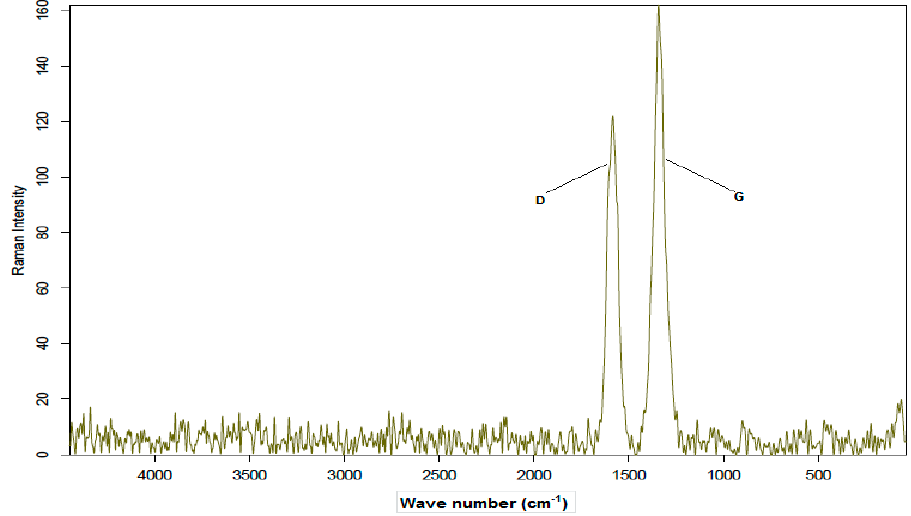
Figure 5. Raman spectrum for the MWCNTs.